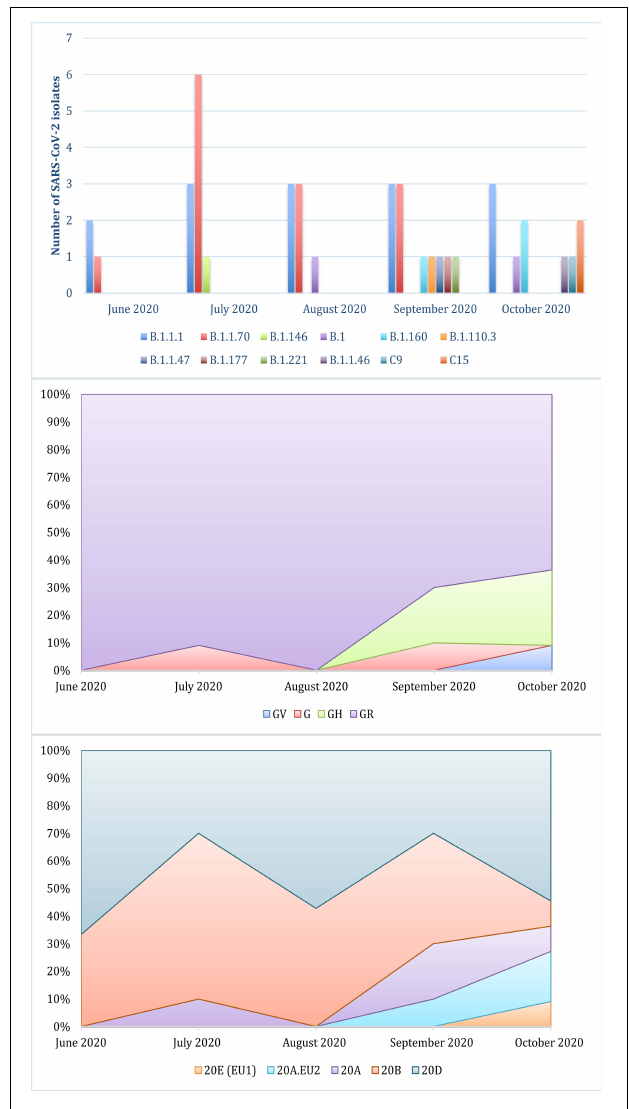
FIGURE 1 | Distribution of lineages and clades of SARS-CoV-2 isolates from the Serbian second wave assigned by PANGOLIN, GISAID, and NEXTRAIN from the top to the